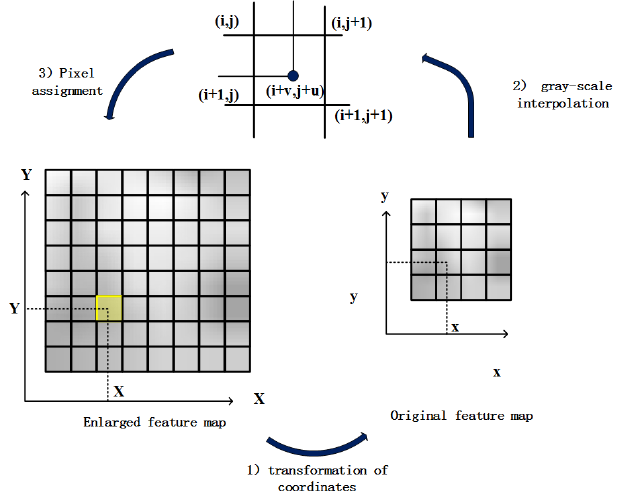
Figure 6. Flow diagram of bilinear interpolation to enlarge feature map.